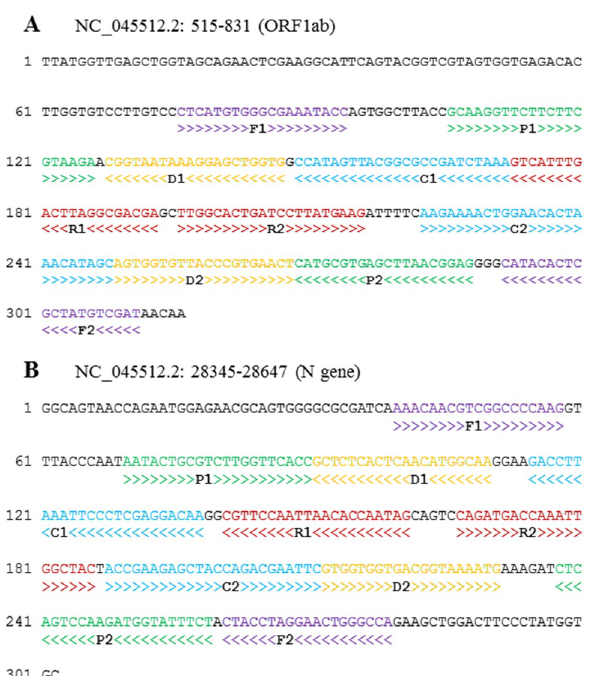
Figure 2. The nucleotide sequences and position of the final (A) ORF1ab and (B) N gene COVID-19 SARS- CoV-2 MCDA primer sets chosen in this study. Right and left arrows show sense and complementary sequences, respectively while coloured text indicates the position of primers: F1/F2 displacement primers in purple, P1/ P2 primers in green, C1/C2 amplification primers in blue, D1/D2 amplification primers in yellow and R1/R2 amplification primers in